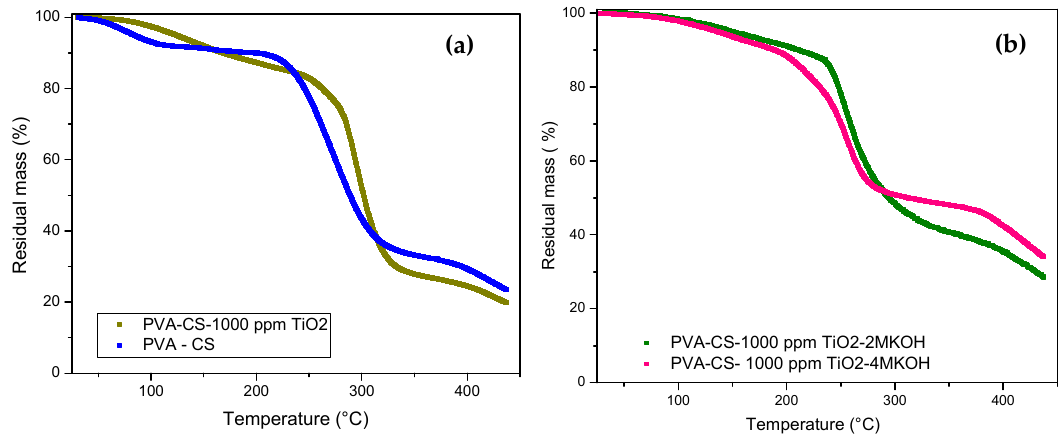
Figure 4. TGA curves for membranes: ( a ) composites. ( b ) KOH-doped compounds.